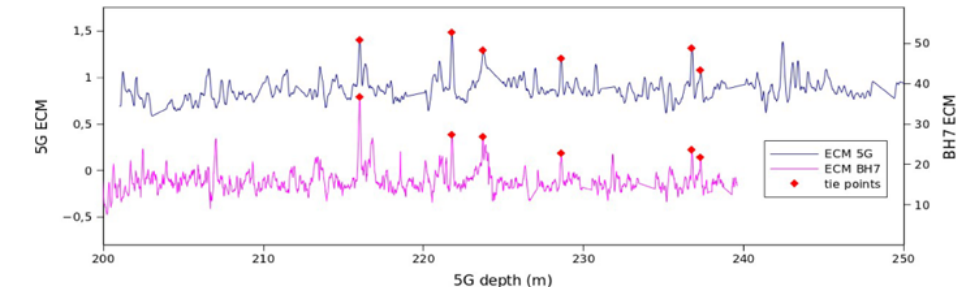
Fig. 5. Volcanic synchronisation of the VK-BH7 and VK-5G ice cores using the ECM